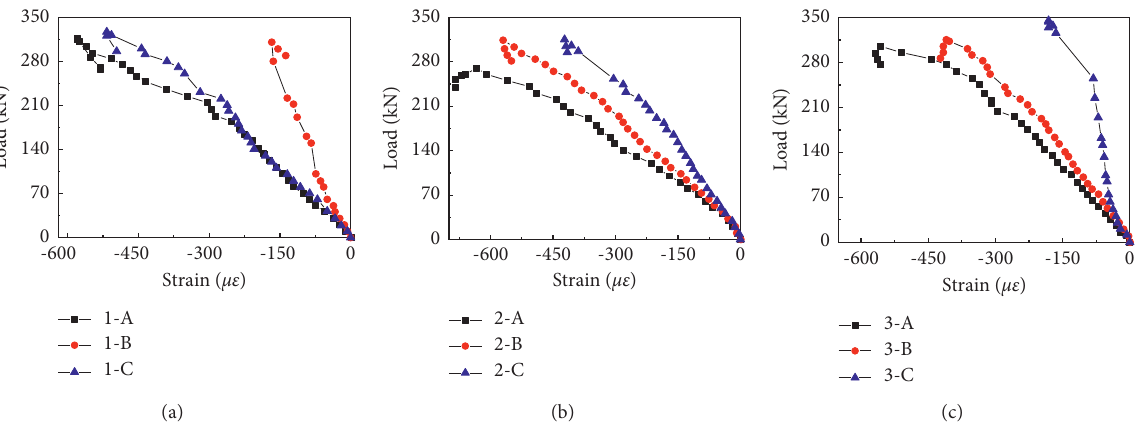
Figure 16: Load-strain curves of No. 34 measuring point on the front of the shear key concrete. (a) First group. (b) Second group. (c) Third